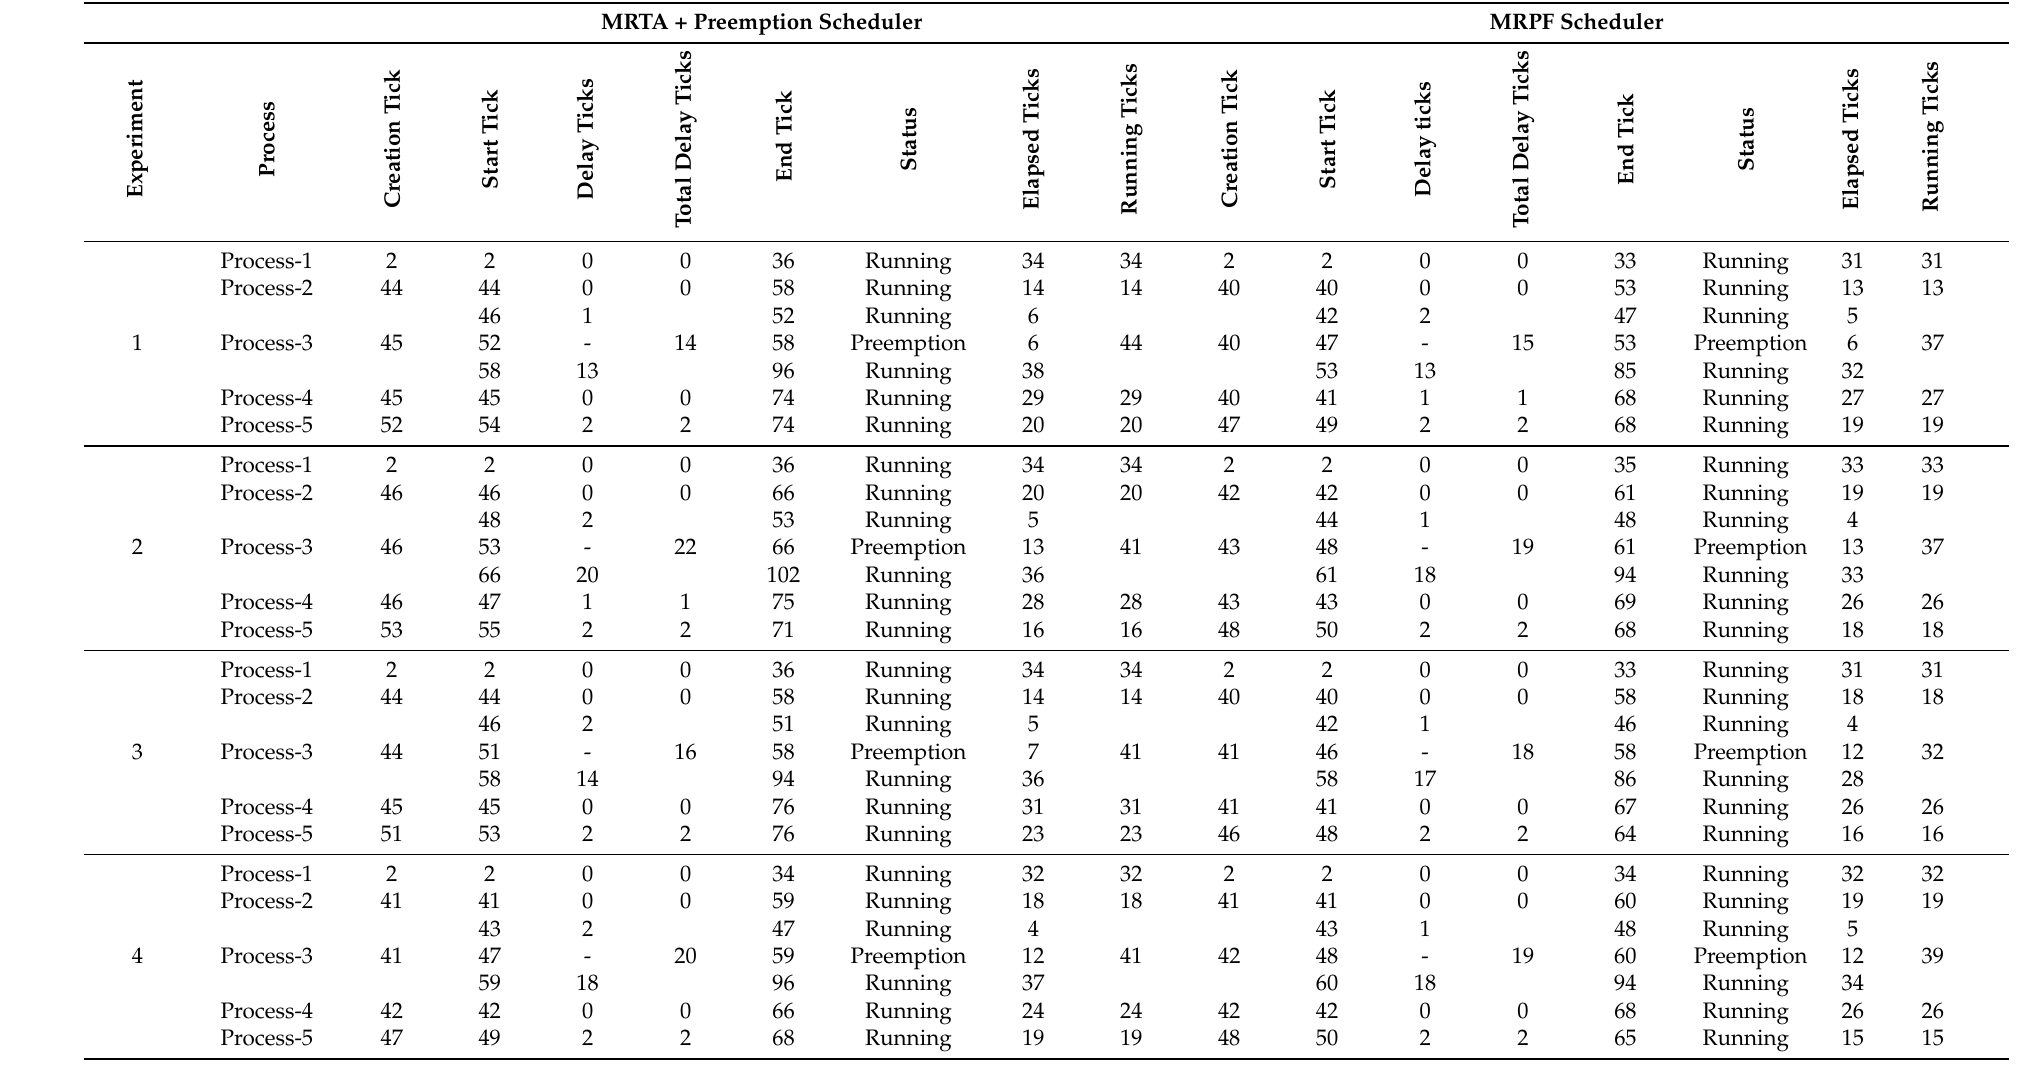
Table 6. MRTA+Preemption and MRPF schedulers